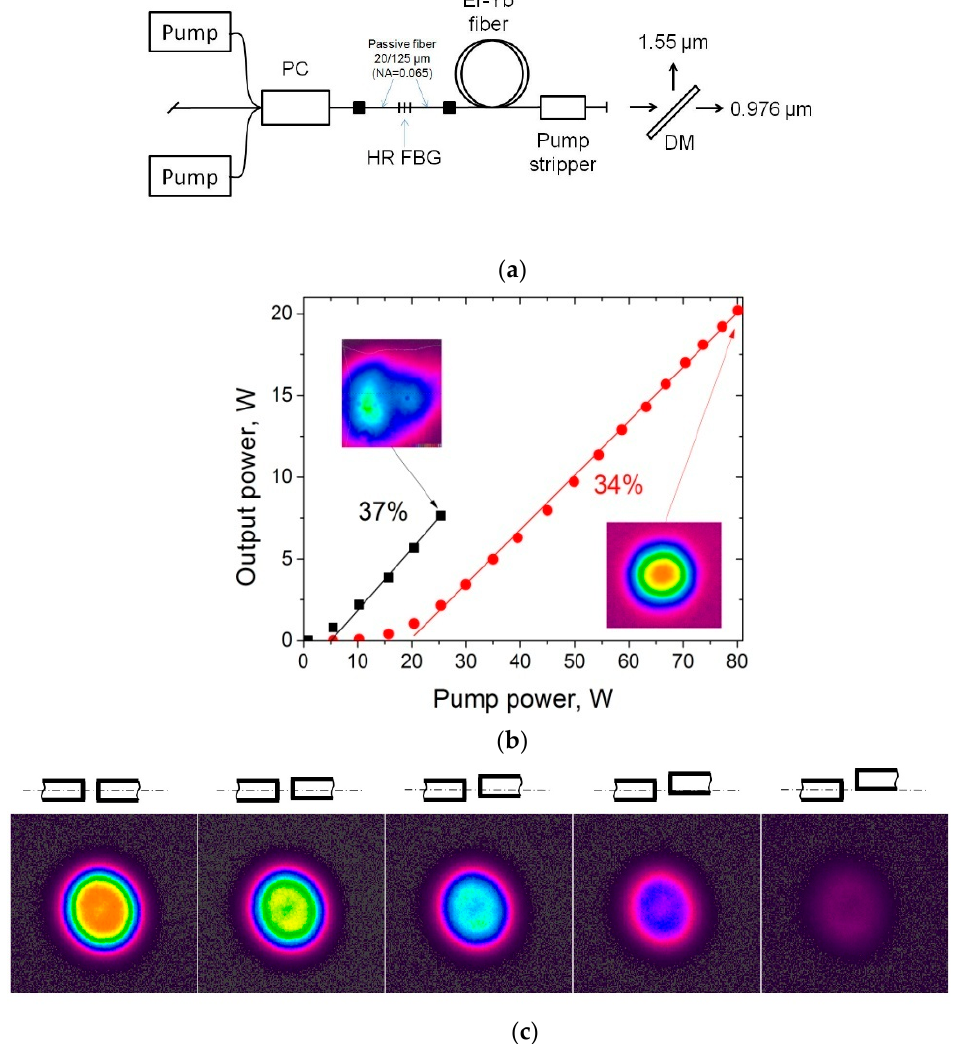
Figure 7. ( a ): The laser setup scheme; ( b ): the dependence of the output power on the input pump power in the fibers: Nufern LMA-EYDF-25P/300-HE (black); ASL-116 (red). Inserts: the fiber ends images at a maximum output power (for Nufern fiber we have shown the image obtained for a coiling diameter of 20 cm to illustrate propagation problem in this fiber that is revealed to be a non-single mode regime); ( c ): the mode propagation images were obtained with a Spiricon SP-1550M camera at the output end of the unpumped ASL-116 fiber with a fiber length of about 0.5 m for different positions (shift from the fiber axis) of the excitation beam (a pump at 1555 nm from single-mode fiber SMF28 was used for excitation–and the schematic fiber’s core layout is shown above each of the corresponding mode image).